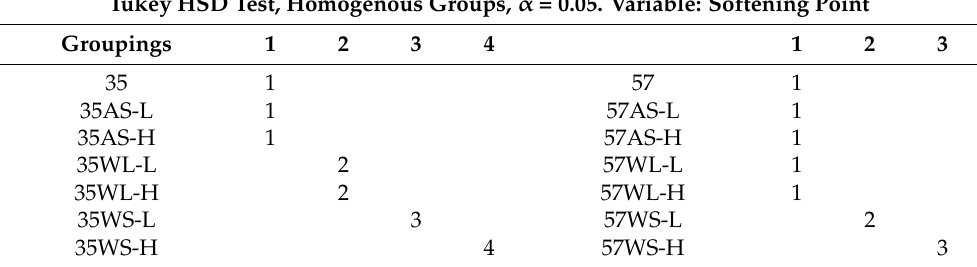
Table 4. Results of Tukey HSD tests for distinguishing homogenous groups (softening point, α = 0.05) within the tested bituminous binders.